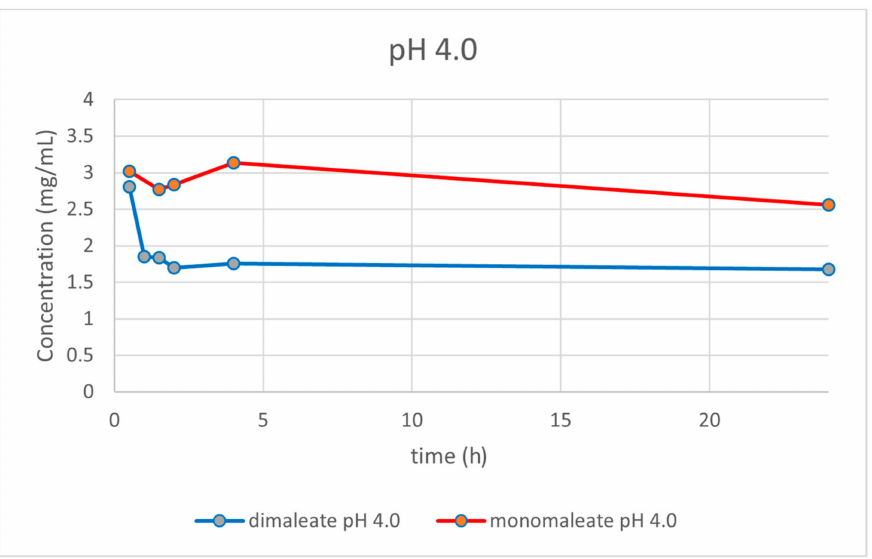
Figure 15. Dissolution testing of glasdegib monomaleate and glasdegib dimaleate at pH = 4.0. At pH = 5.5 (Figure 16) the dissolution curves were similar compared to those obtained at pH = 1.2, slightly rising over time. After 24 h, glasdegib dimaleate had higher solubility (3.02 mg/mL) compared to the glasdegib monomaleate (2.28 mg/mL).